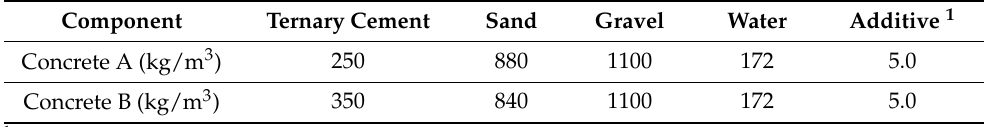
Table 5. Concrete mix design for each concrete, A & B (kg/m 3 ).